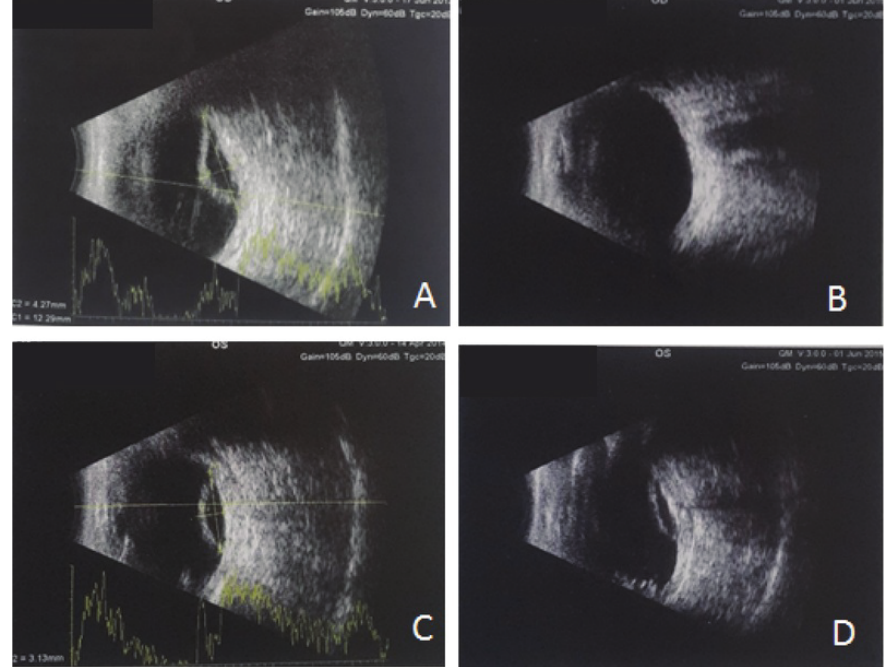
Figure 1. (A) Right eye B-scan before latanoprost treatment. (B) Serous choroidal detachment resolution after treatment with high- dose latanoprost in the right eye. (C) Left eye B-scan before latanoprost treatment. (D) Serous choroidal detachment improvement after treatment in the left